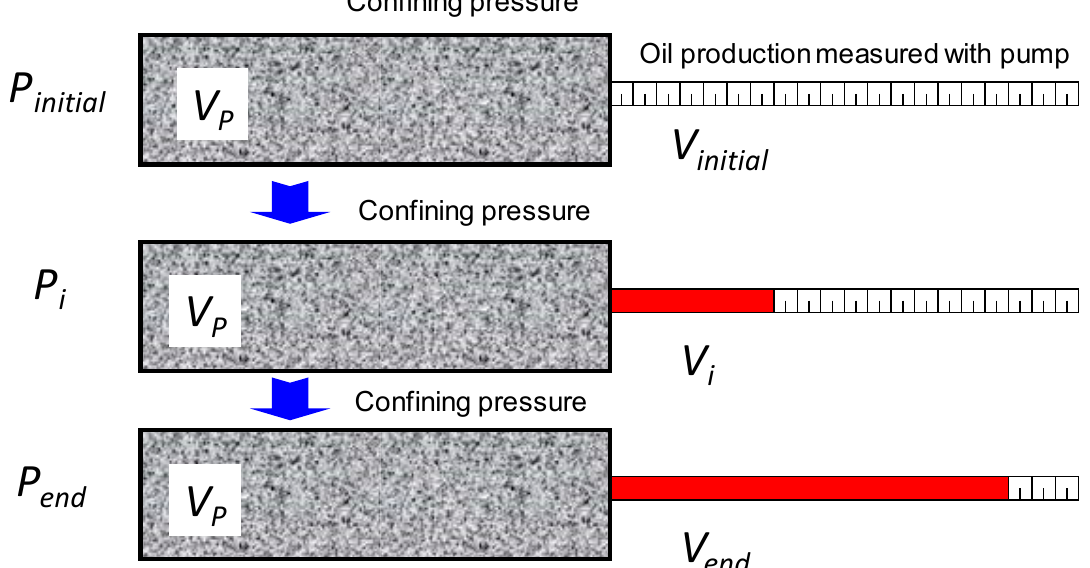
Figure 3. A schematic diagram for the oil production measurement during pressure depletion.